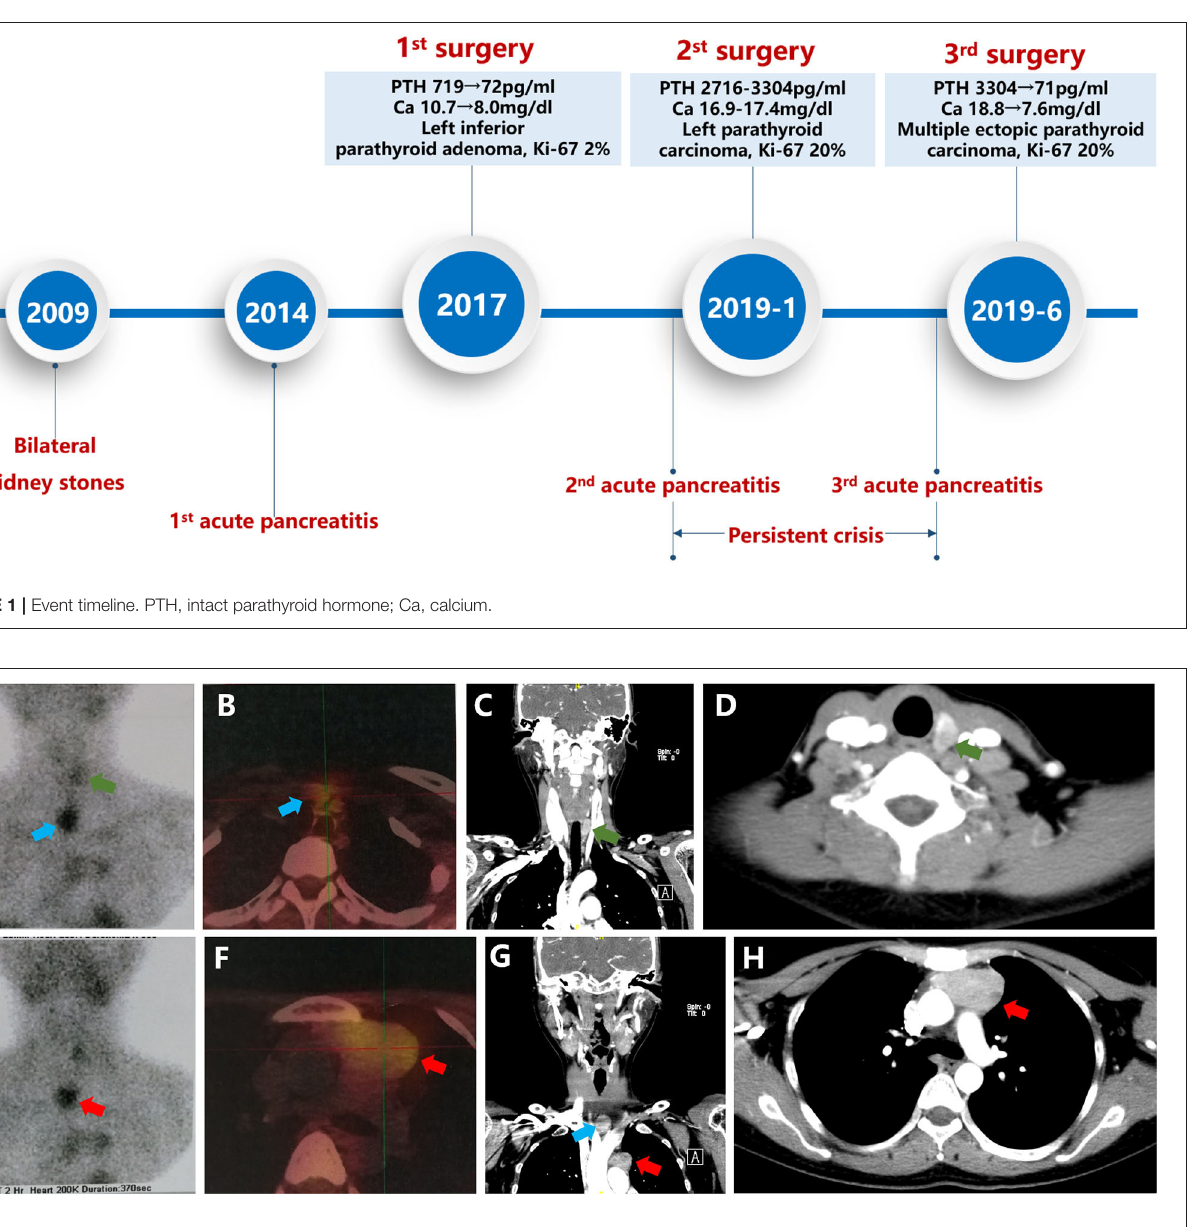
FIGURE 2 | Imaging findings. (A,B,E,F) Technetium-99 methoxyisobutylisonitrile (99mTc-MIBI) imaging; (C,D,G,H) Enhanced computed tomography scanning. Green arrow for the parathyroid carcinoma in left inferior thyroid region, blue arrow for the carcinoma in the suprasternal fossa, and red arrow for the carcinoma in the thymic